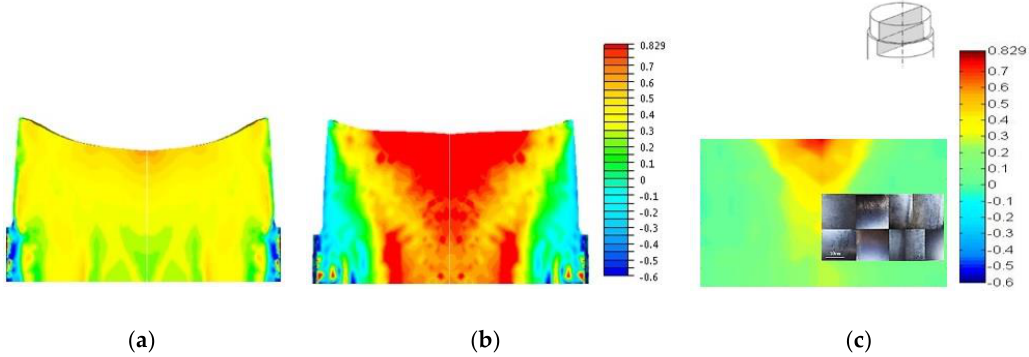
Figure 12. Segregation pattern of carbon on the axial surface of the hot-top and upper section of ingot ( a ) lever rule; ( b ) Scheil; ( c ) mass spectrometer measurements with macrostructure around the hot-top/ingot junction.